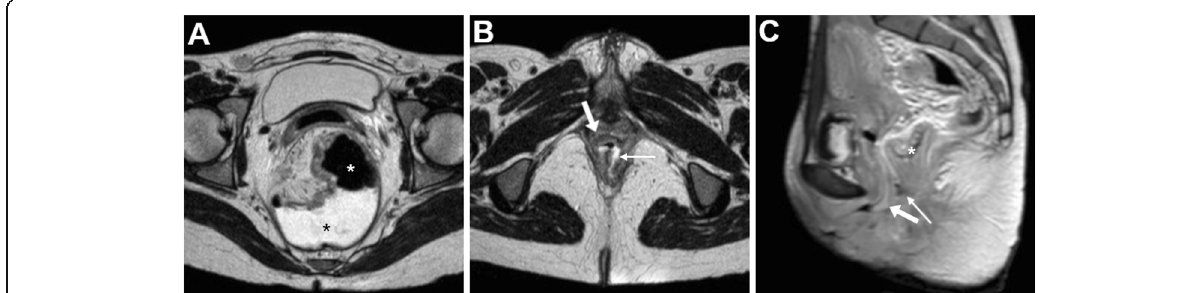
Fig. 9 Ano-VF following total proctocolectomy with ileal pouch-anal anastomosis (IPAA) in a 44-year-old with ulcerative colitis. Axial T2-weighted ( a , b ) and sagittal post-gadolinium T1-weighted ( c ) MRI images show fluid distension of the ileal pouch (*) and a small midline fistula (thin arrows) connecting the IPAA to the vagina (arrow)